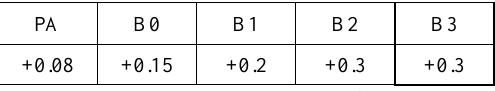
Table 2. NeDLI evolution during the first 3